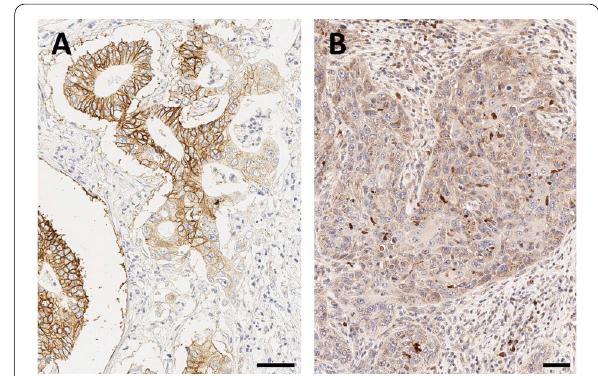
Fig. 4 β8-integrin immunohistochemistry of pancreatic ductal adenocarcinoma (PDAC, A ) and head-and-neck squamous cell carcinoma (HNSCC, B ). Bars indicate 50 µm. Note that the β8-subunit dimerizes only with the ubiquitous αv (see Fig. 1), which is why β8-IHC is indicative for actual αvβ8